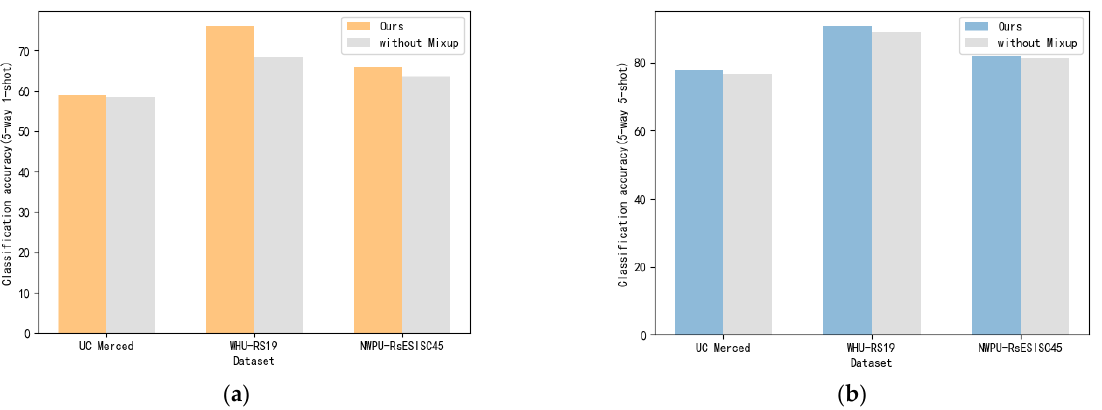
feature extraction from training samples in this dataset.